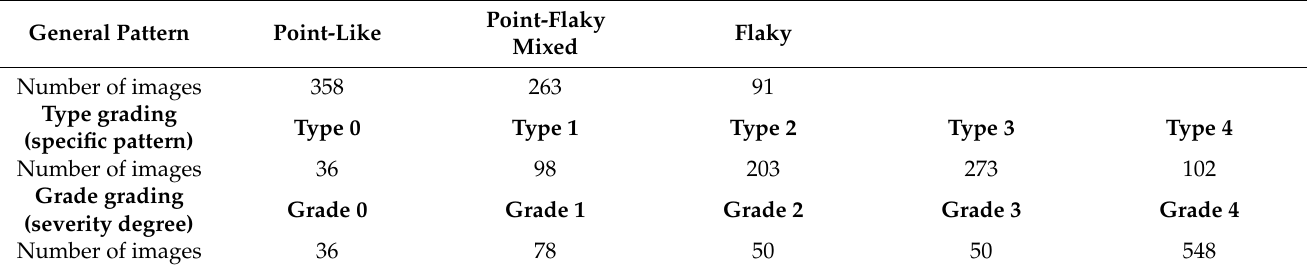
Table 1. The distribution of the images used in the system.